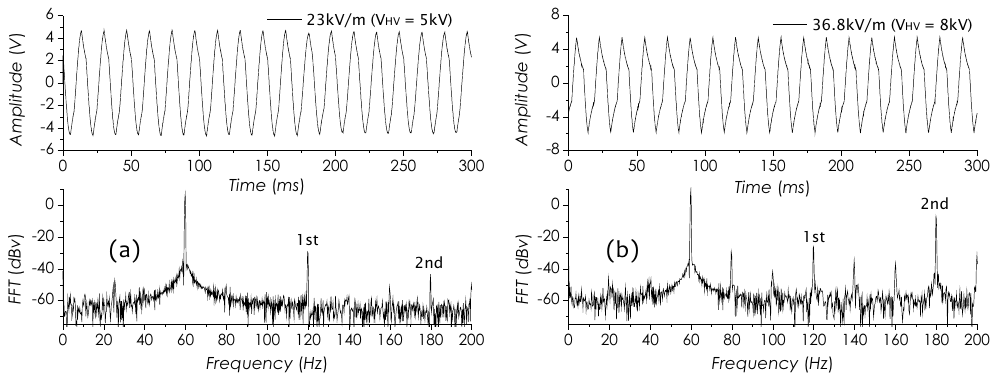
Figure 11. Measured E -field signals and FFT spectra at ( a ) E 0 = 23 kV/m and ( b ) E 0 = 36.8